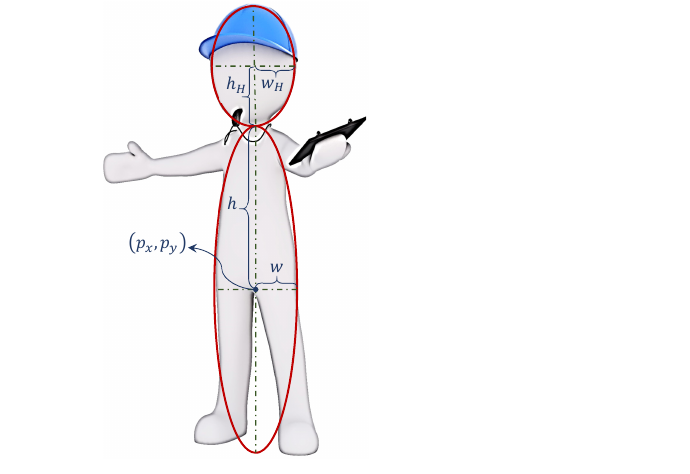
Figure 1. The model used for single human targets in the visual tracking for industrial mobile platform